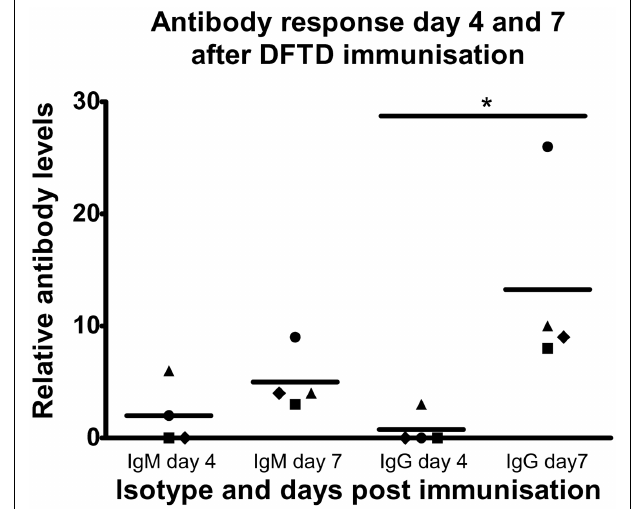
FIGURE 4 | C57BL/6 mice were injected IP with 10 6 DFTD cells and serum was collected 4 and 7days post injection . All samples were analyzed in the same flow cytometry experiment to permit direct comparison of mouse anti-DFTD IgG and IgM in the serum. Mean fluorescence intensity ratio of samples compared to pooled naïve mouse serum was used as a relative measure of antibody expression.There was no significant difference in the mean of IgM expression for all four mice (represented by different plot symbols) compared on days 4 and 7 post injection.There was a significant difference of IgG expression between days 4 and 7 ( P < 0.05; probability calculated by a paired Student’s t